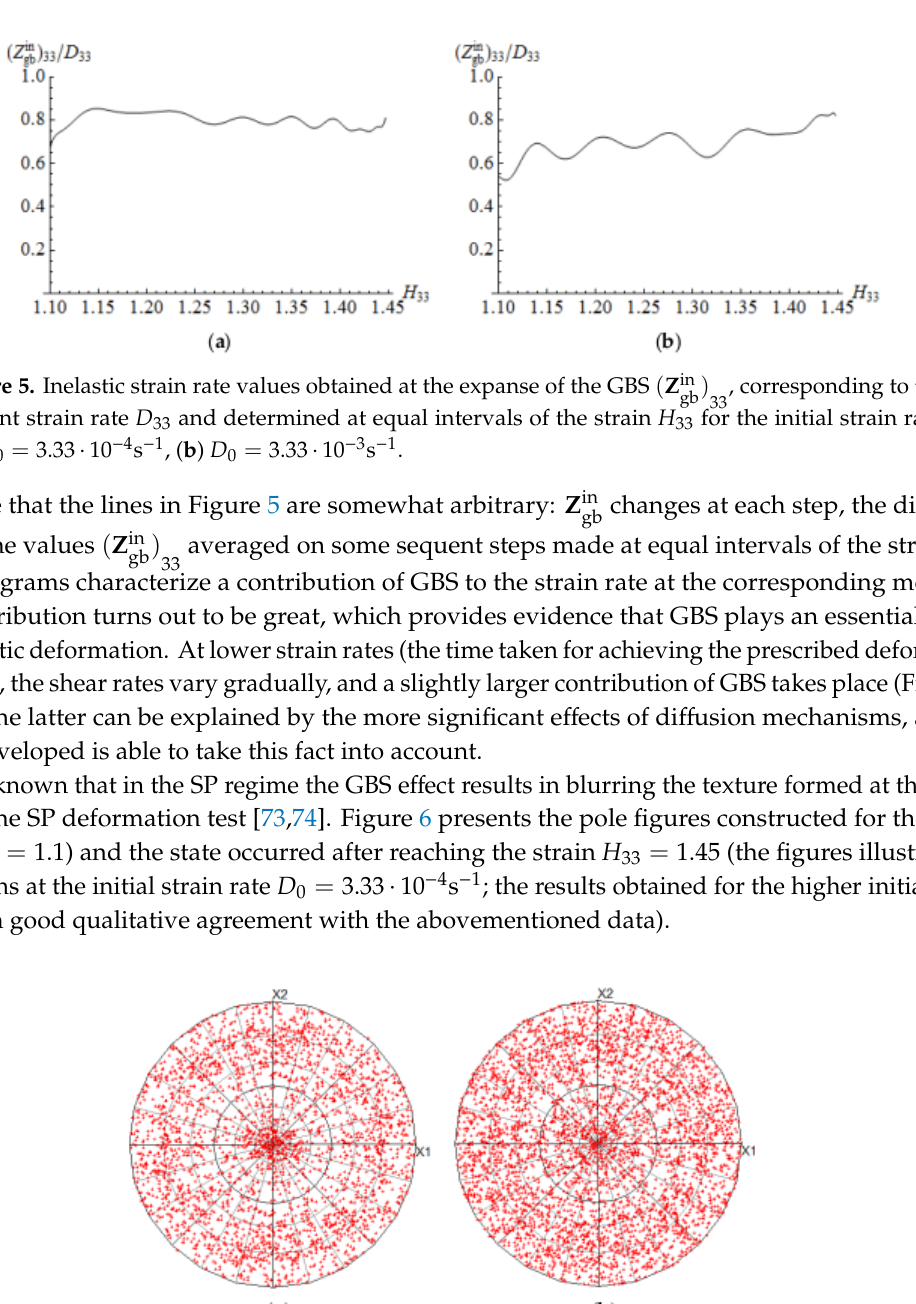
) , corresponding to the gb 33